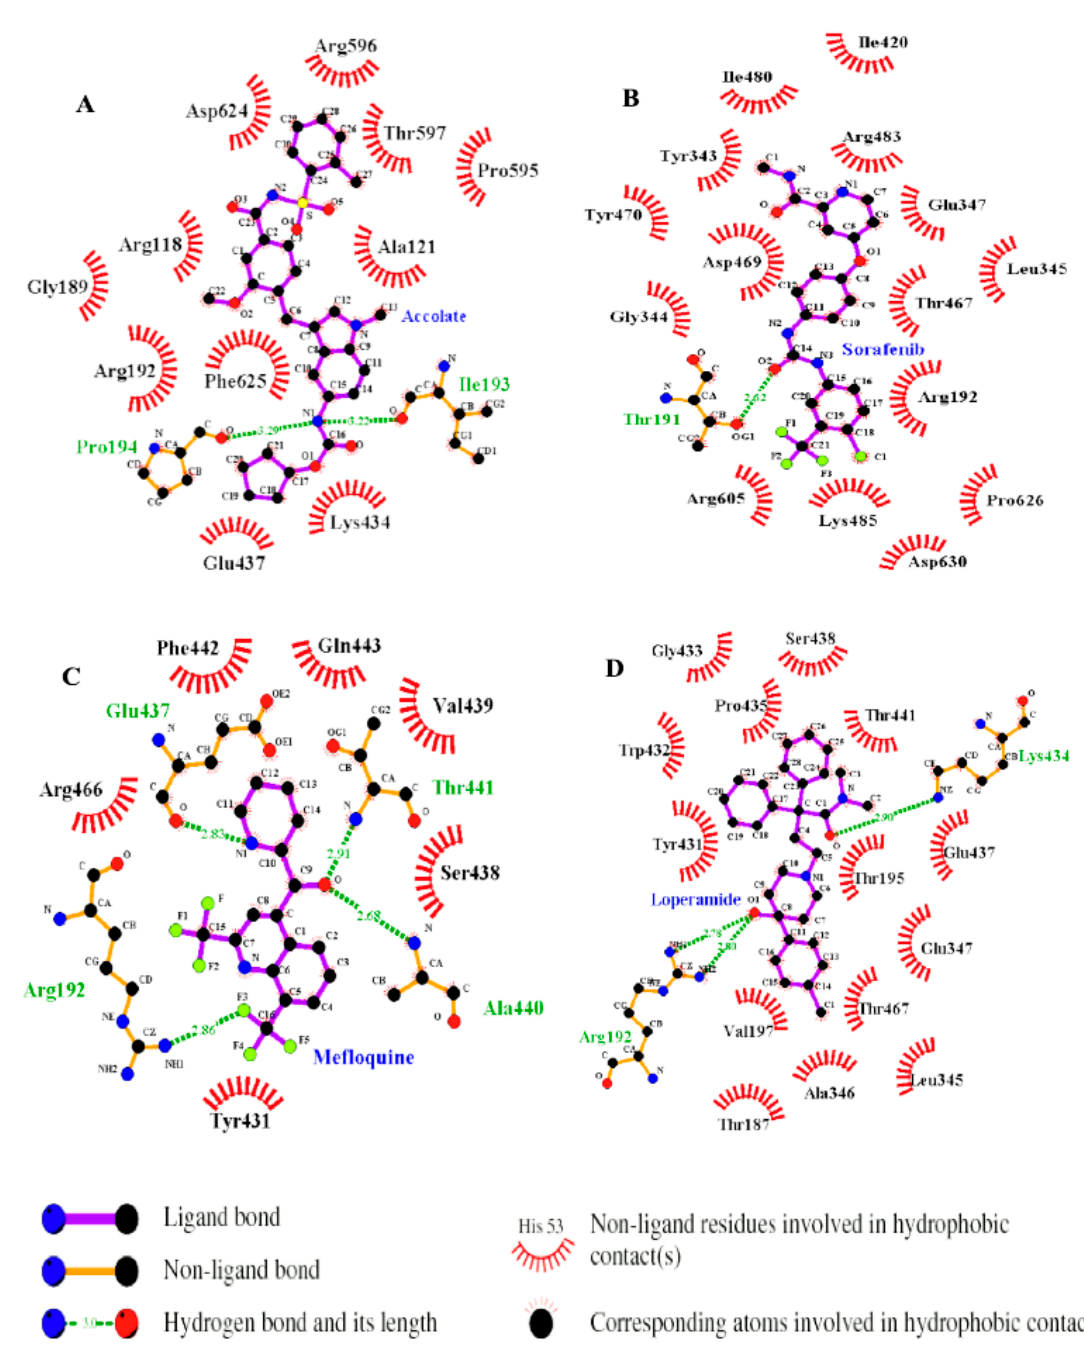
Figure 3. Interaction profile of FadD32-Accolate ( A ), FadD32-Sorafenib ( B ), FadD32-Mefloquine ( C ), and FadD32-Loperamide ( D ).